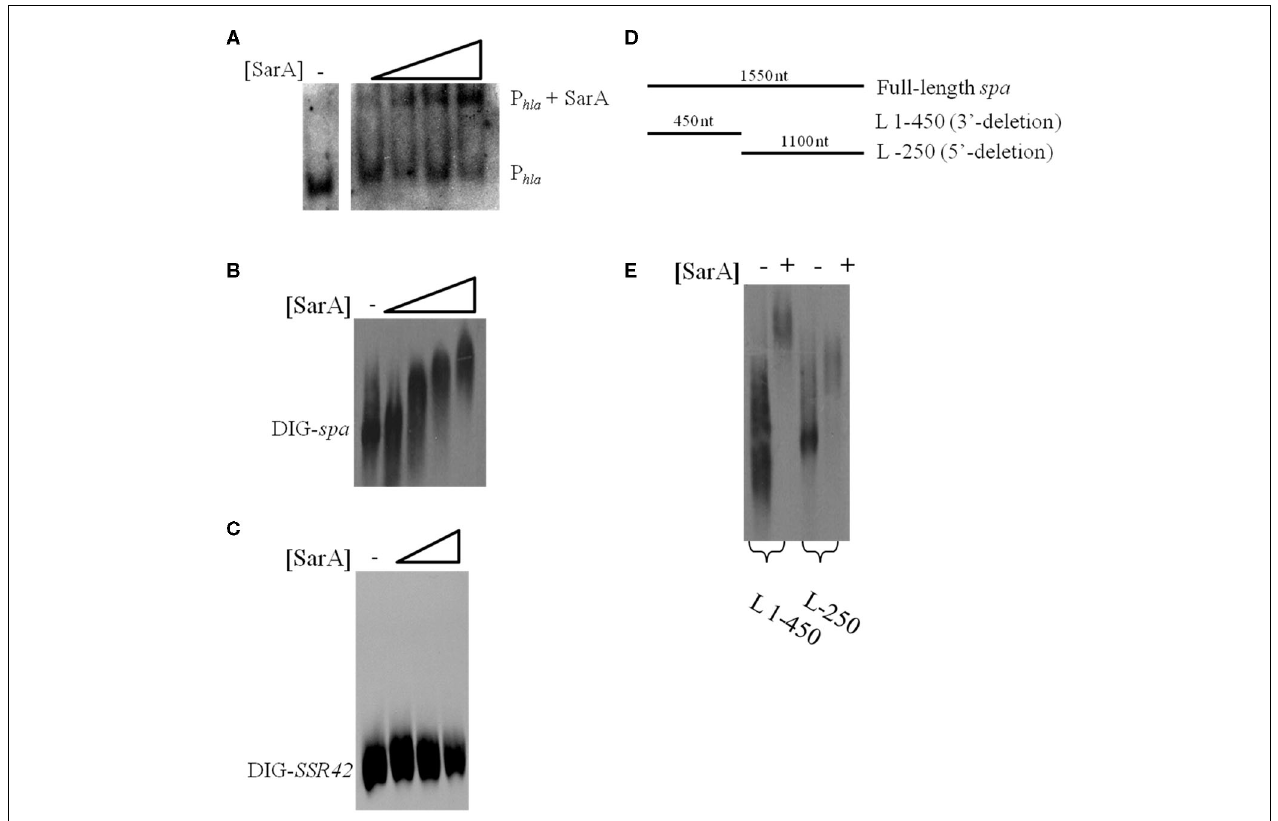
mobility shift assays evaluating the mobility of DIG-labeled, in vitro transcribed SSR42 in the presence of increasing concentrations of SarA protein (0, 36.6, 73.3, or 366.5pmol). (D) Schematic of transcript variants containing deletions of 3 (cid:3) or 5 (cid:3) regions of spa that were DIG-labeled for use